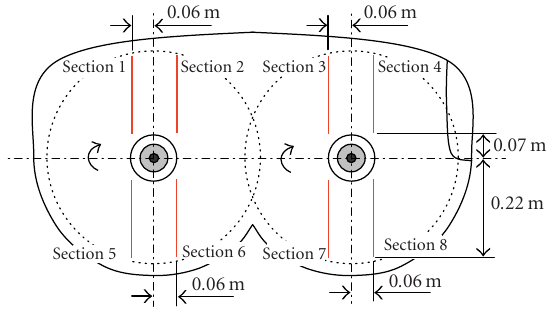
Figure 6: Selected sections for LDV